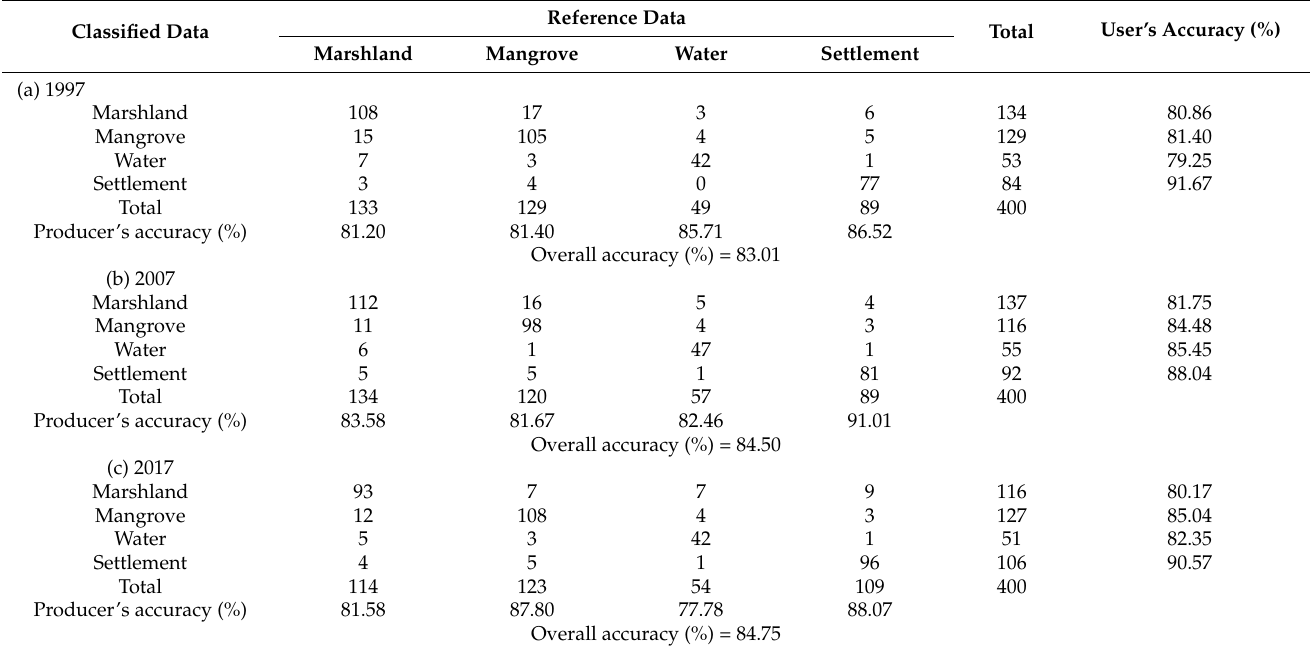
Table A1. Confusion matrices of the classified LUC maps of the